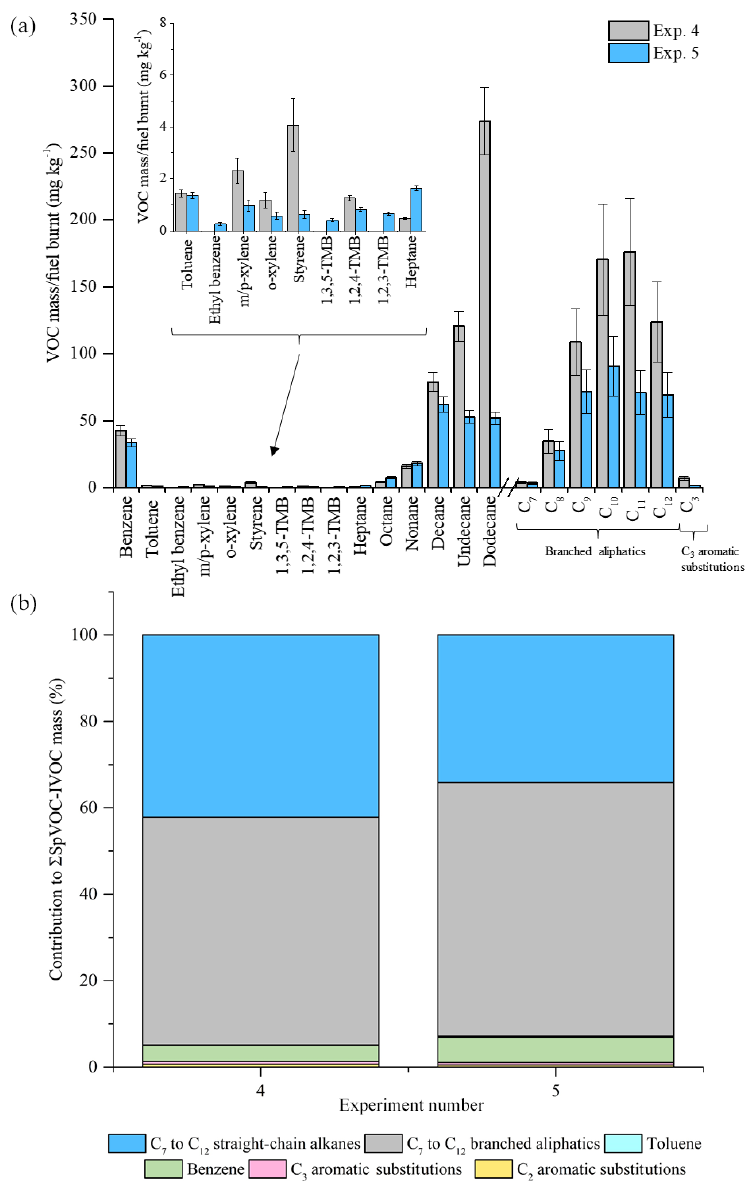
Figure 6. Comparison of measured VOC-IVOC emission rates in replicate warm with load experiments 4 and 5 (2000rpm, 30% load) (a) . Comparison of the percentage contribution of the individual and grouped compounds to the P SpVOC-IVOC emission rates in exps. 4 and 5 (b) . The emission rates of tridecane and the C 13 branched aliphatic grouping has not been included in (b) to allow direct comparison between other experiments where these species were not measured. Error bars represent the calculated uncertainty in the measured emission rates, see Sect. 1.1 for further